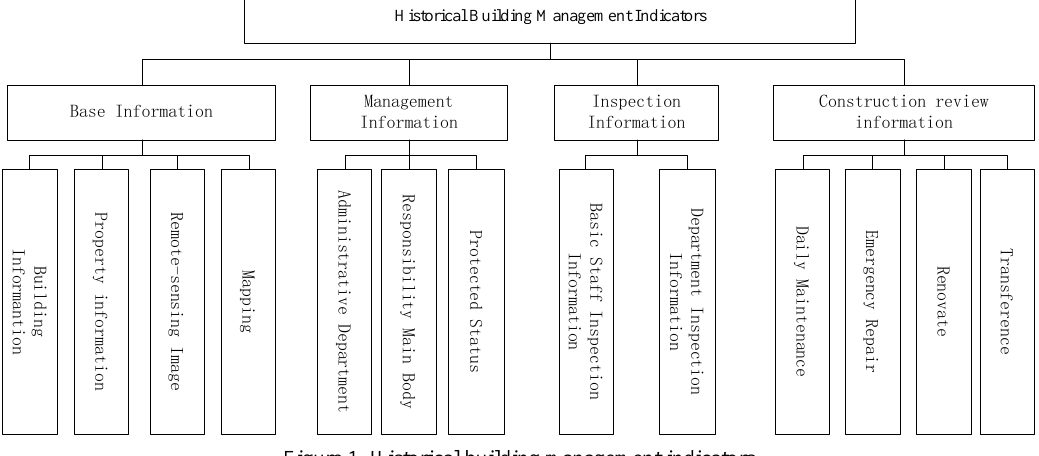
Figure 1. Historical building management